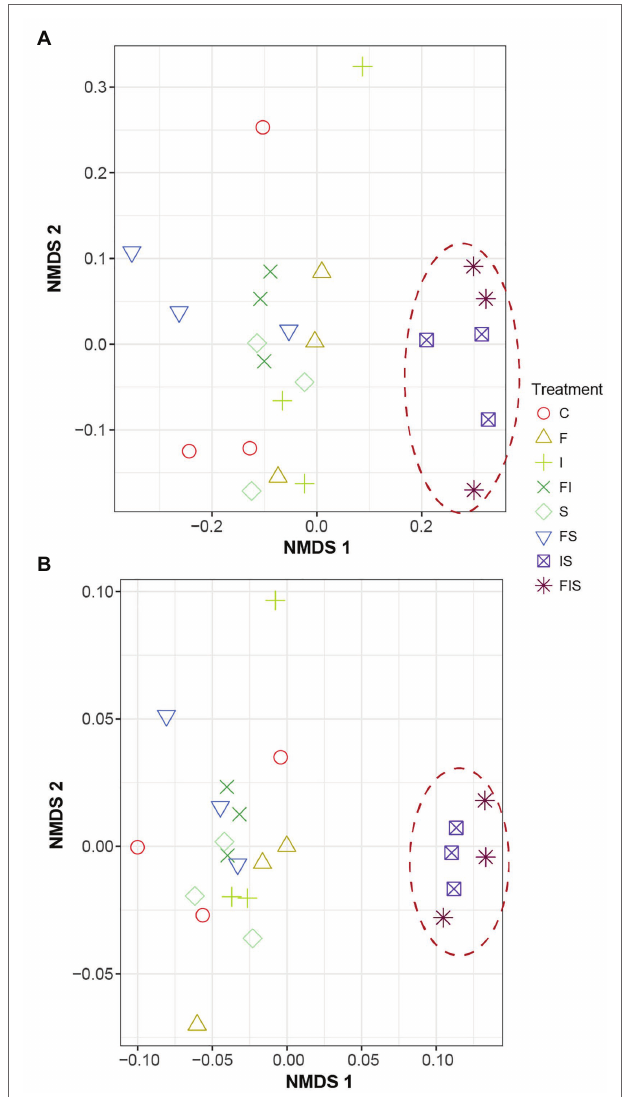
FIGURE 5 | Non-metric multidimensional distance scaling (NMDS) analysis of the composition of the rhizosphere microbial communities among treatments at V15. (A) Taxonomic similarity (Bray-Curtis) and (B) phylogenetic similarity (weighted UniFrac). Treatments: C, Control; F, Urea-topdressing fertilization at V5; I, A. brasilense inoculant on seeds sowing; FI, F + I; S, Maize stover coverage; FS, F + S; IS, I + S; FIS, F + I +